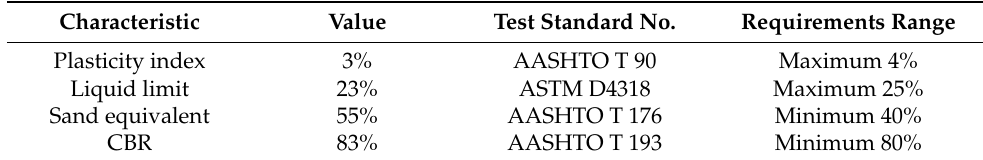
Table 1. Characteristics of the employed soil as the base layer material.